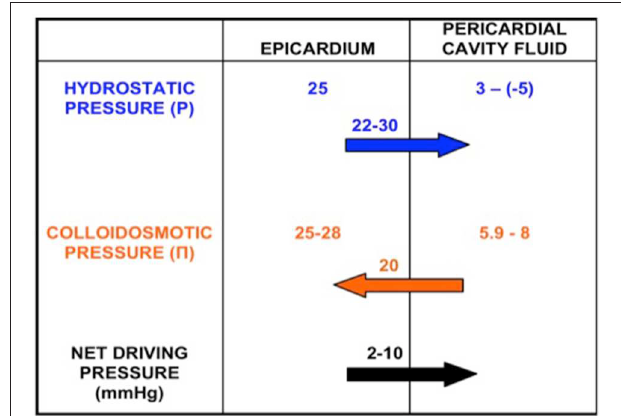
FIGURE 1 | Production of pericardial fluid as a net pressure phenomenon. Epicardial and pericardial cavity hydrostatic (P) and colloidosmotic ( 5 ) pressures. There is a net pressure difference of 2–10mmHg that drives the fluid from the epicardium toward the pericardial cavity.